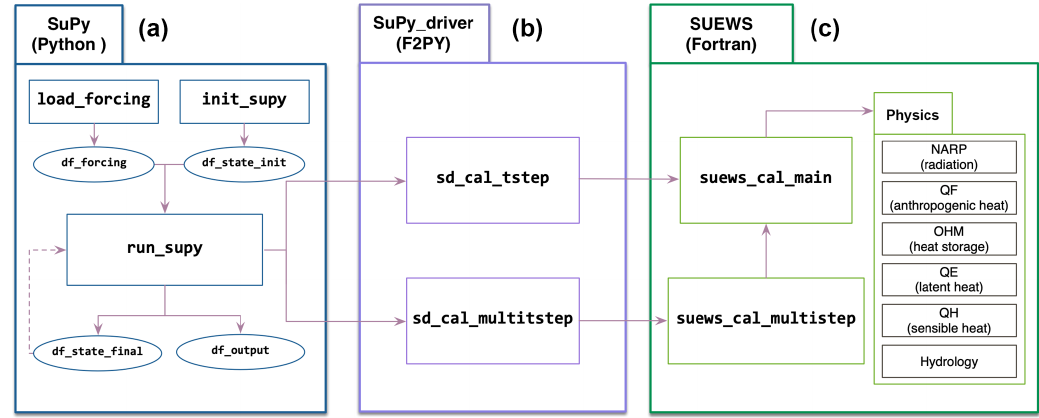
Figure 1. SuPy’s three major components (left to right): (a) SuPy, a Python-based front-end processor; (b) SuPy_driver, the